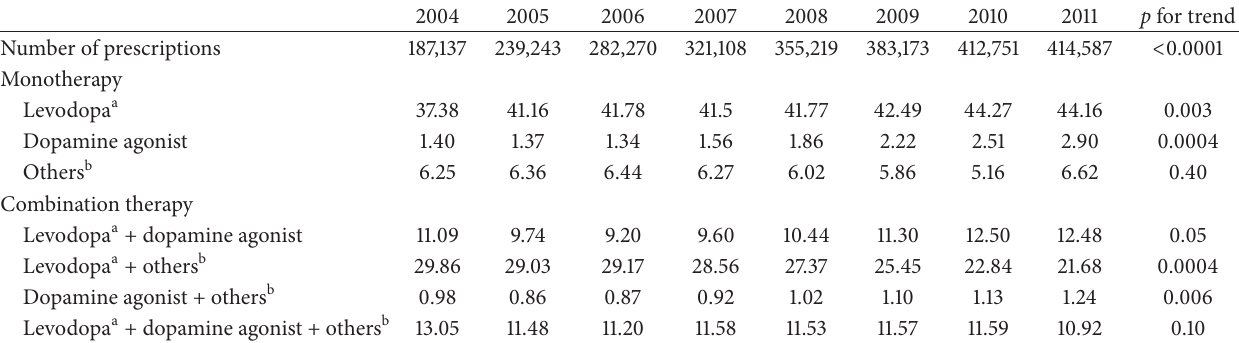
Table 1: Antiparkinsonism drug prescription patterns in Taiwan from 2004 to